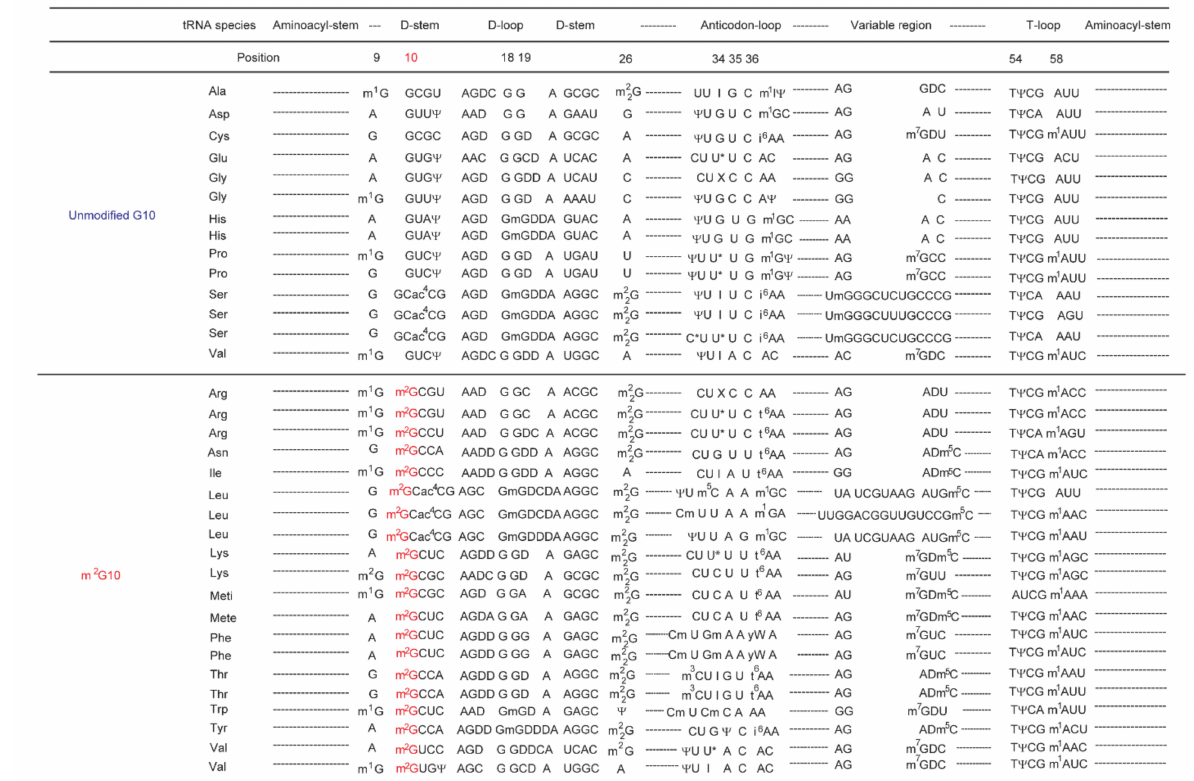
Figure 2. Comparison of S. cerevisiae tRNA sequences. The sequences of D-arms, anticodon- loops, variable regions and T-loops in S. cerevisiae tRNAs are compared. The abbreviations are as follows; m 1 G, 1-methylguanosine; D, dihydrouridine; I, inosine; m 1 I, 1-methylinosine; T, thymidine; Ψ , pseudouridine; i 6 A, N 6 -isopetenyladenosine; m 7 G, 7-methylguanosine; m 1 A, 1- methyladenosine; U*, U-modification; X, unidentified modification; Gm, 2 (cid:48) - O -methylguanosine; Um, 2 (cid:48) - O -methyluridine; ac 4 C, 4-acetylcytidine; m 5 C, 5-methylcytidine; m 3 C, 3-methylcytidine; t 6 A, N 6 -threonylcarbamoyladenosine; and yW, wyosine. The position of a modification caused by Trm11-Trm112 (m 2 G10) is highlighted in red. The sequences in the aminoacyl-stem, anticodon-stem and T-stem are not